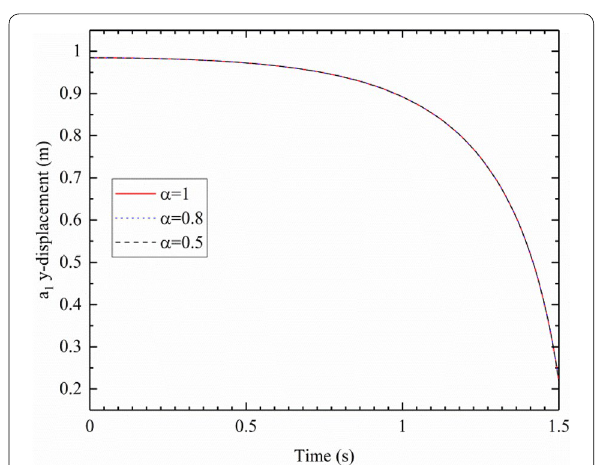
Figure 6 Y -direction displacement of point a